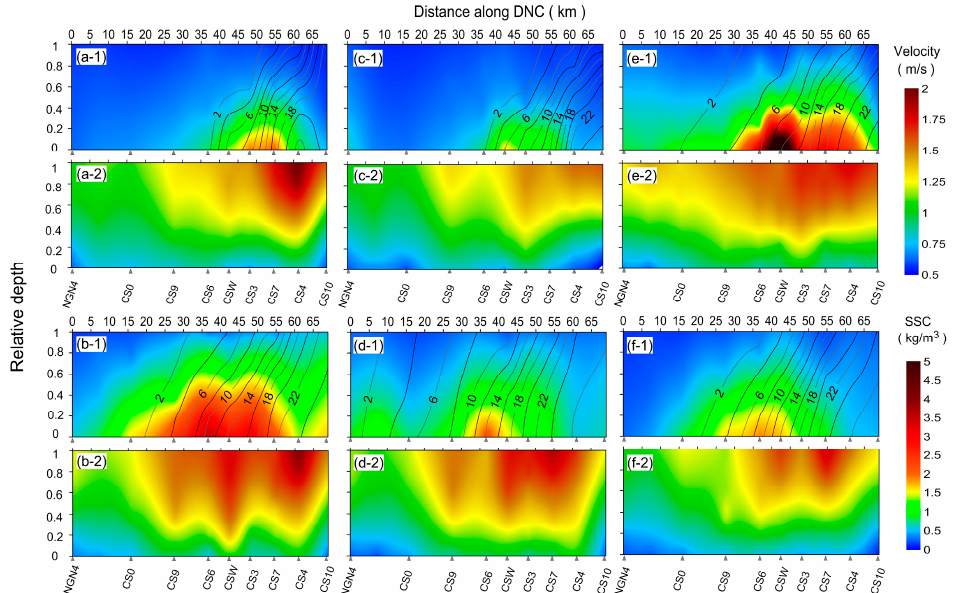
Figure 2. Along-channel distributions of tidal-averaged current velocity magnitude, salinity and suspended sediment concentration (SSC): ( a – f ) represent the wet and dry seasons of 2016, wet and dry seasons of 2017, and wet and dry seasons of 2018 respectively. ( 1 )—SSC and isohalines (with the interval of 2 psu) and ( 2 )—magnitude of tidal-averaged current velocity (calculated by absolute values of current velocities during two flood-ebb tidal cycle and denoting the strength of tidal dynamic). The SSC increased with water depth and reached the maximum at the bottom in all six